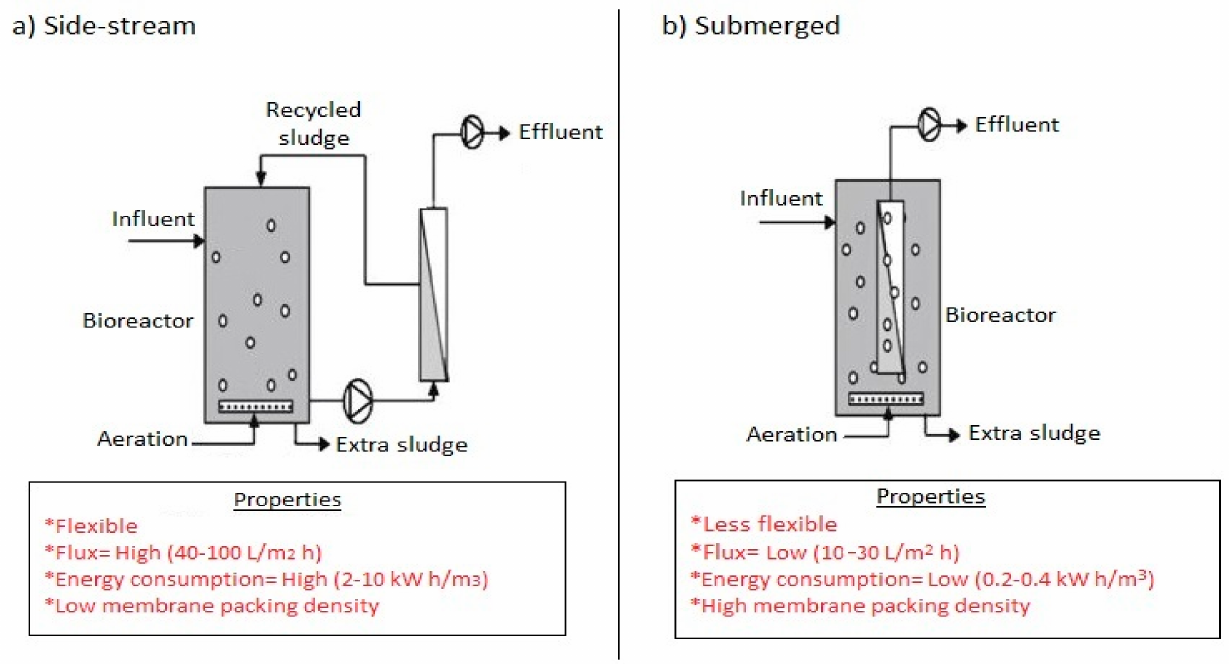
Figure 3. Schematic diagram of ( a ) side stream MBR and ( b ) submerged